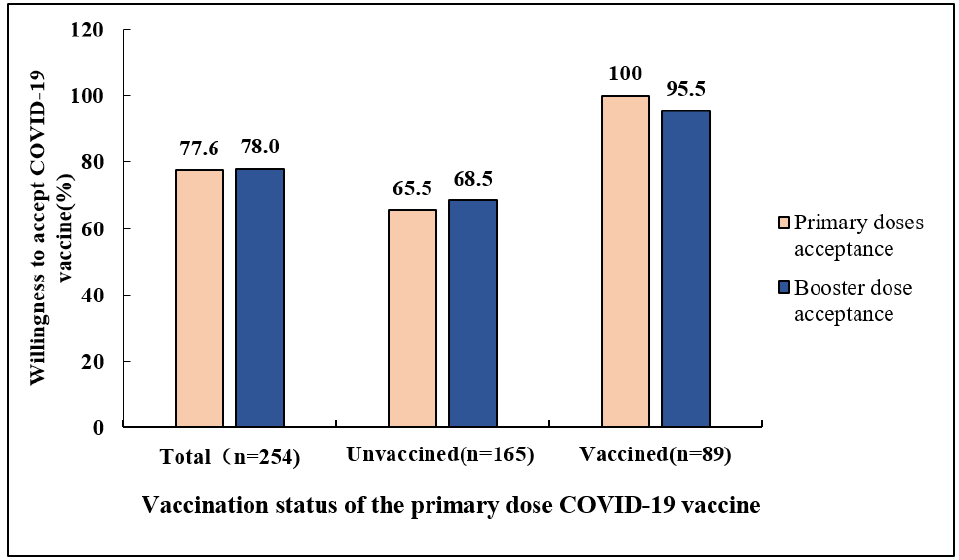
Figure 1. The willingness of older adults with chronic disease to receive a booster dose of COVID-19 vaccine, n = 254.